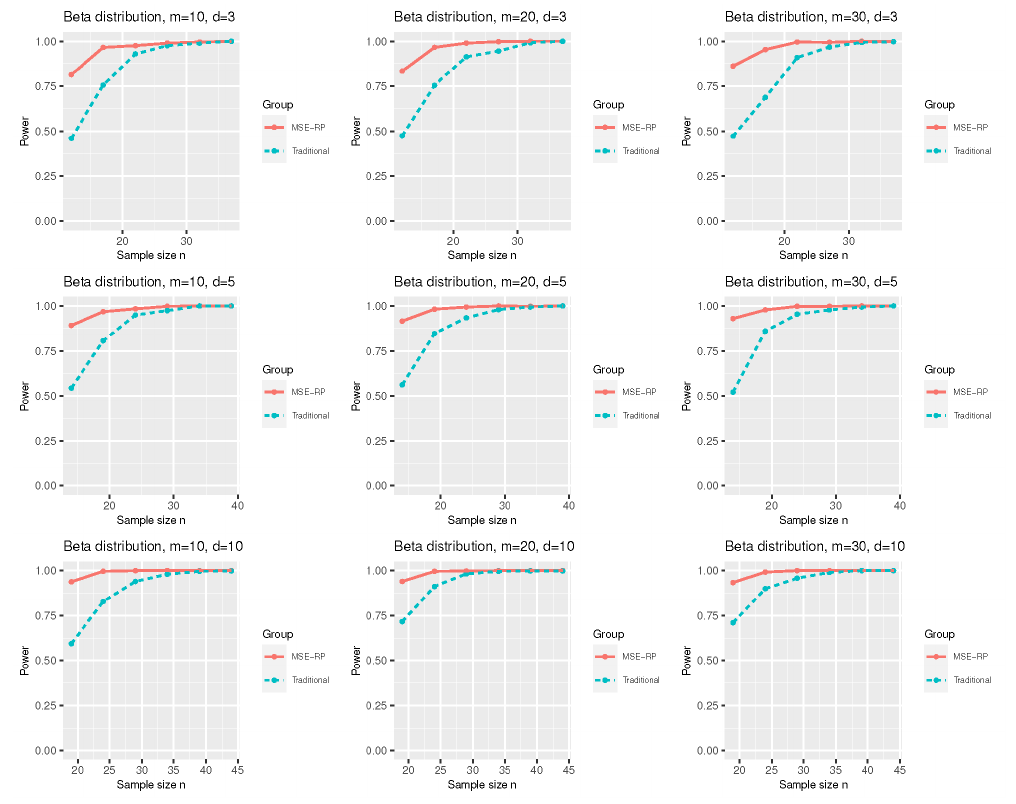
Figure 2. Power ( α = 0.05) in β g-normal distribution.